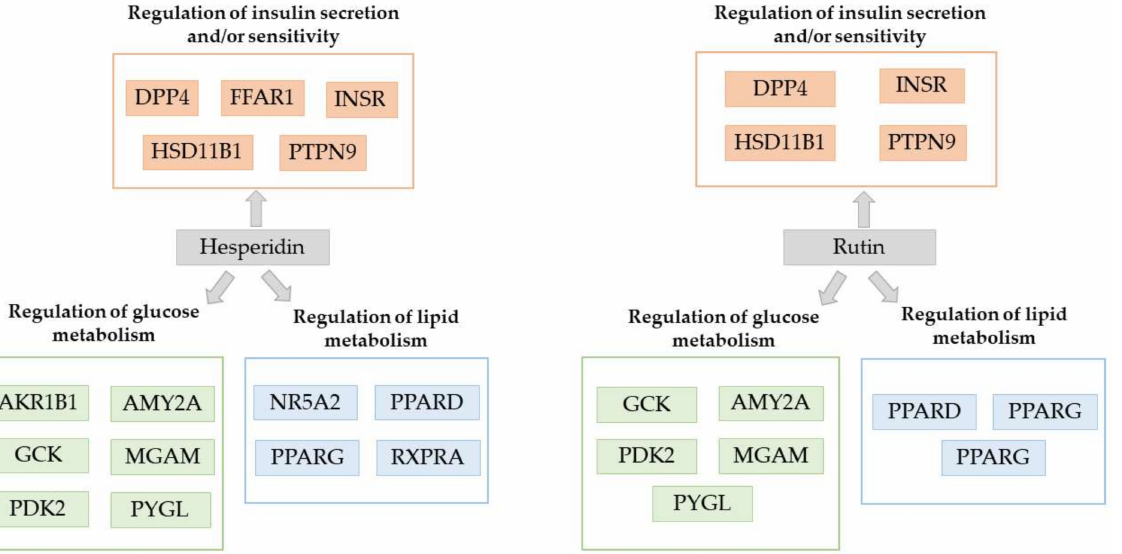
Figure 2. Interaction of hesperidin and rutin with protein targets related with diabetes mellitus as predicted with the employment of DIA-DB inverse virtual screening web